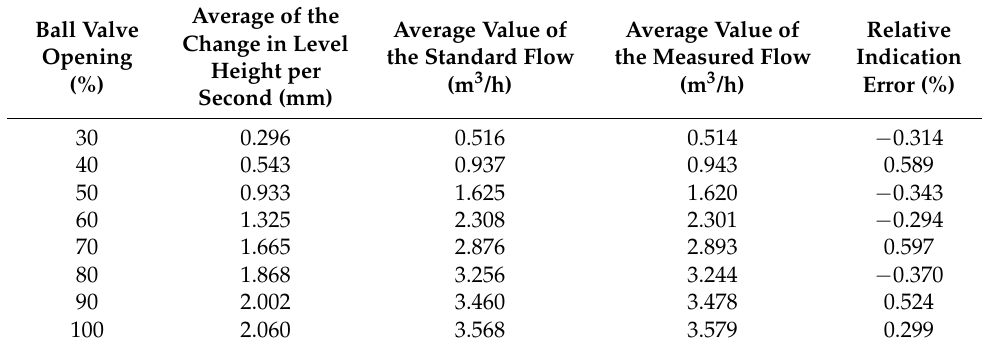
Table 5. Measurement results under DN26 pipe diameter.